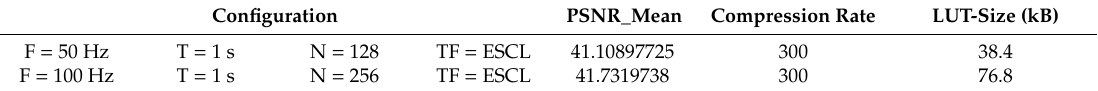
Figure 13. PSNR distribution and mean value (x) vs. the target function (F = 50 Hz, T = 1 s, N = 256).